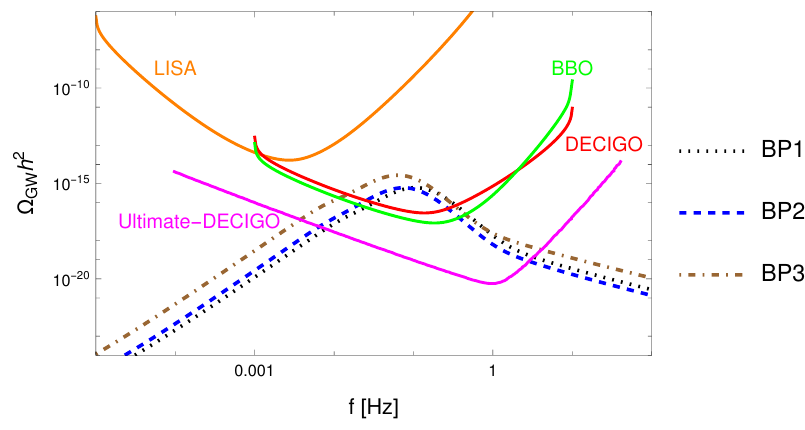
Figure 17 . FOPT-associated GW spectra for our three BPs summarised in table 2. The black dotted line corresponds to the first BP, the blue dashed line depicts the second BPs, and the brown dot-dashed line represents the third BP. The sensitivity curves of future space-base GW experiments, including LISA, BBO, DECIGO, and Ultimate-DECIGO, are shown as well. We consulted ref. [195] for the data for LISA, BBO, and DECIGO, and ref. [196] for the Ultimate-DECIGO.